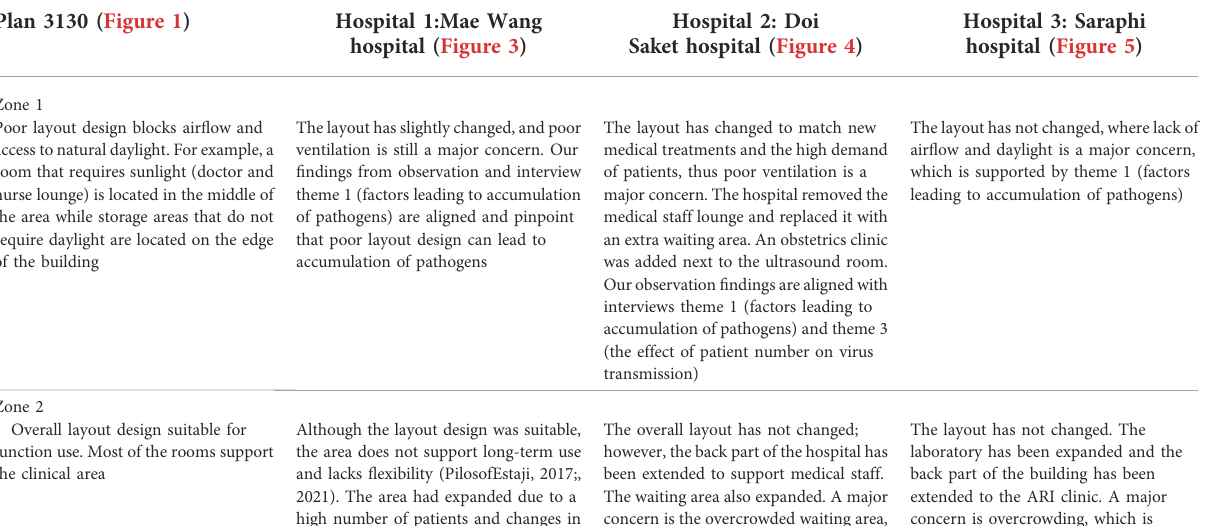
TABLE 4 Comparison between 3130 standard and each community hospital